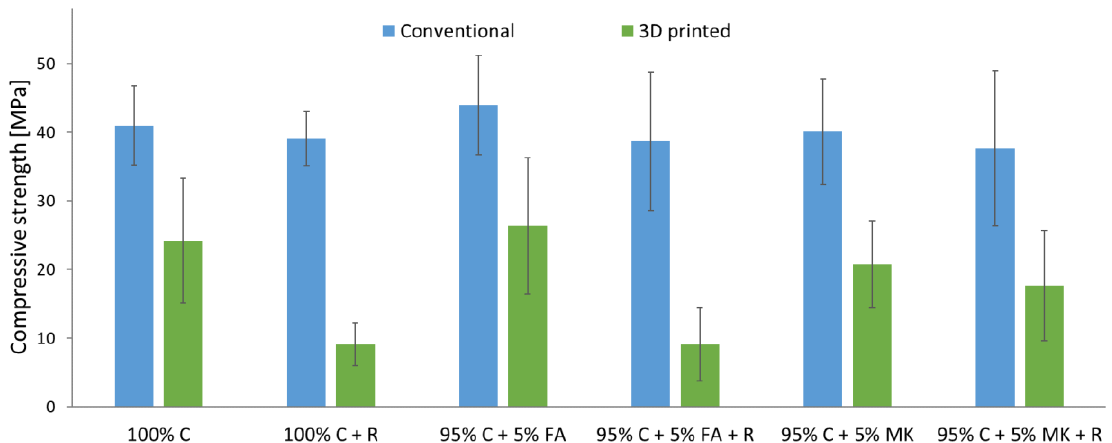
Figure 4. Compressive strength of concrete and concrete – geopolymer hybrids produced by casting and 3D printing.